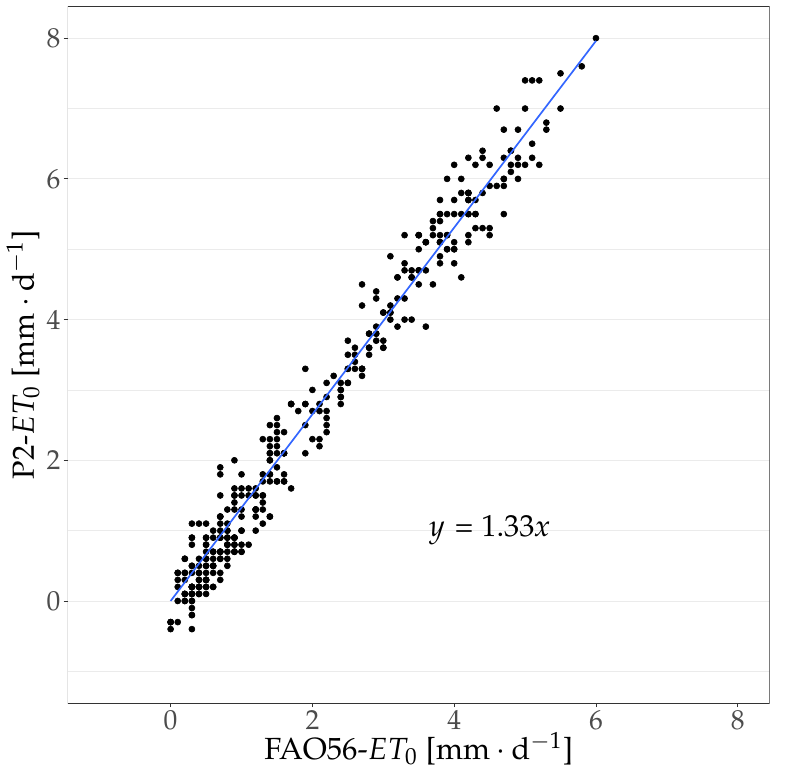
Figure 1. Simple linear regression model (blue line) for P2- ET 0 year 2009, Geisenheim,